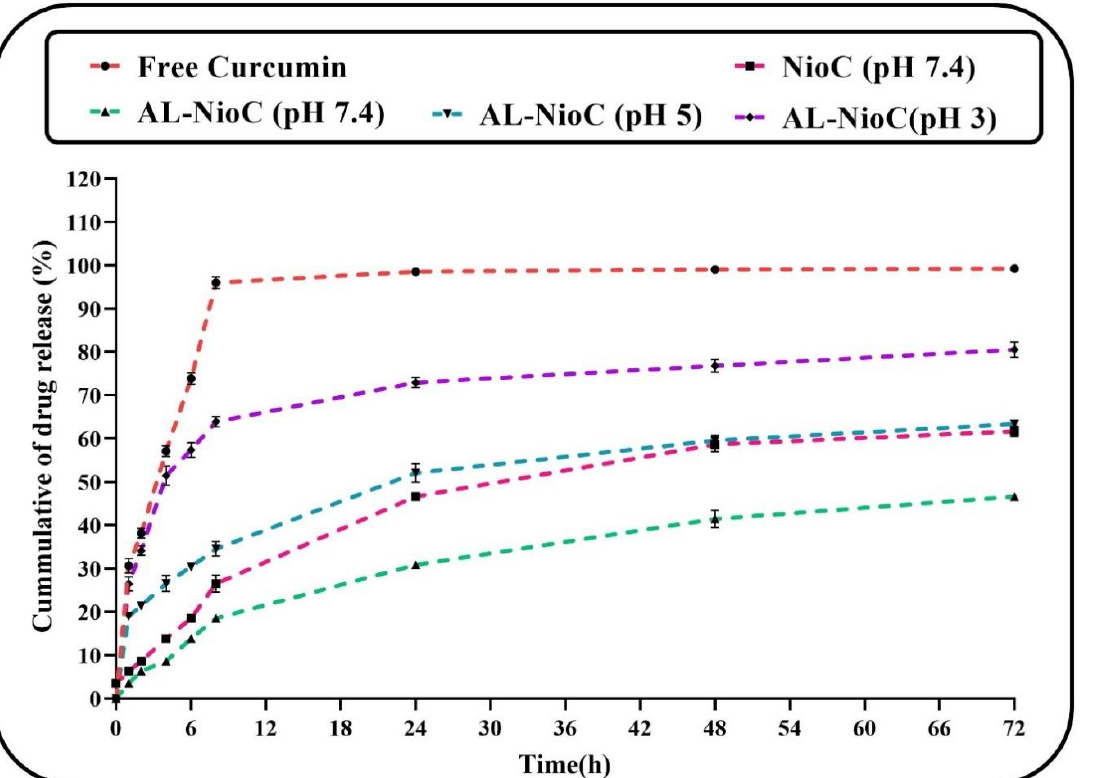
Free Curcumin-pH 7.4